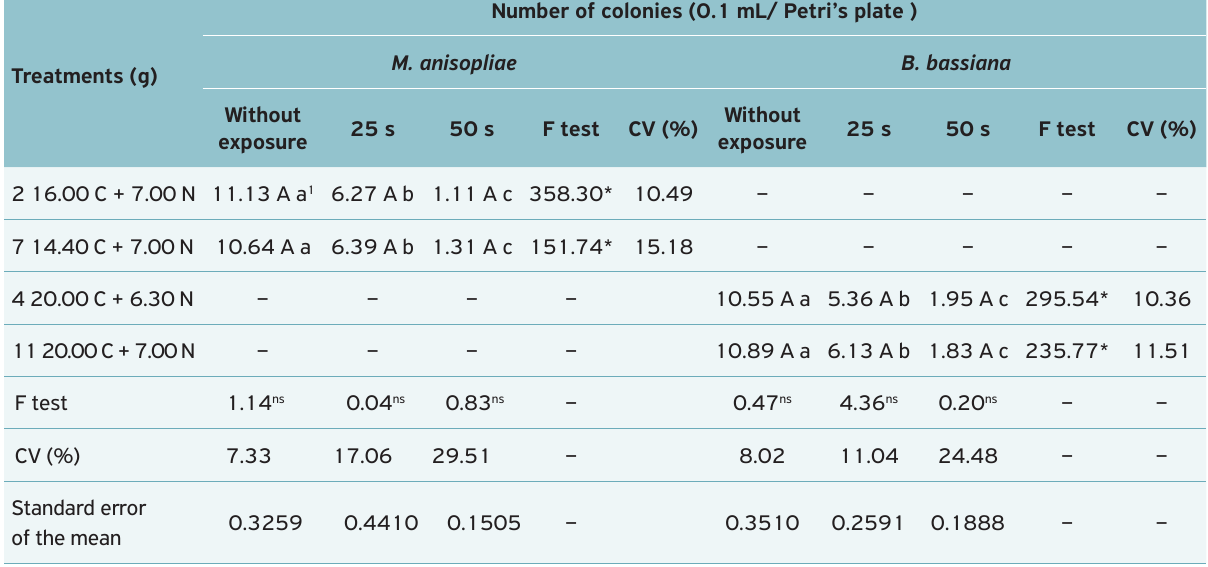
Table 5. Number of colonies obtained from Metarhizium anisopliae (IBCB 425) and Beauveria bassiana (IBCB 66) after exposure of blastospores to ultraviolet radiation for 25 and 50 seconds, and incubation of three days (at 25 ± 1°C and 12-hour